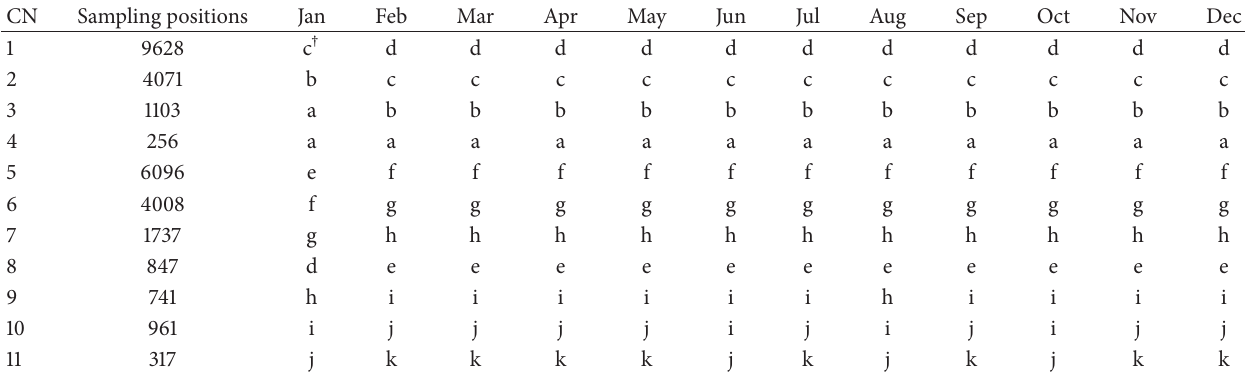
Table 4: Number of sampling positions within each cluster and ANOVA-LSD comparisons of the mean values of the dependent variable between the 11 clusters for each